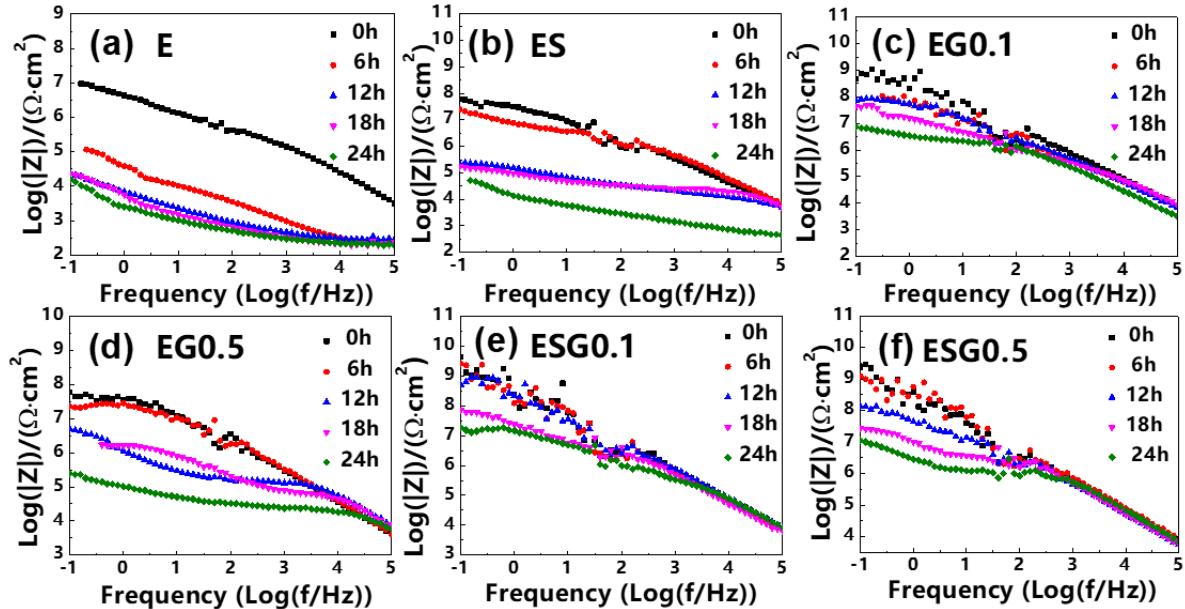
Figure 8. Time-dependent Bode plots of the coatings during 24 h of immersion in 3.5% NaCl aqueous solution: ( a ) E, ( b ) ES, ( c ) EG0.1, ( d ) EG0.5, ( e ) ESG0.1, and ( f ) ESG0.5.